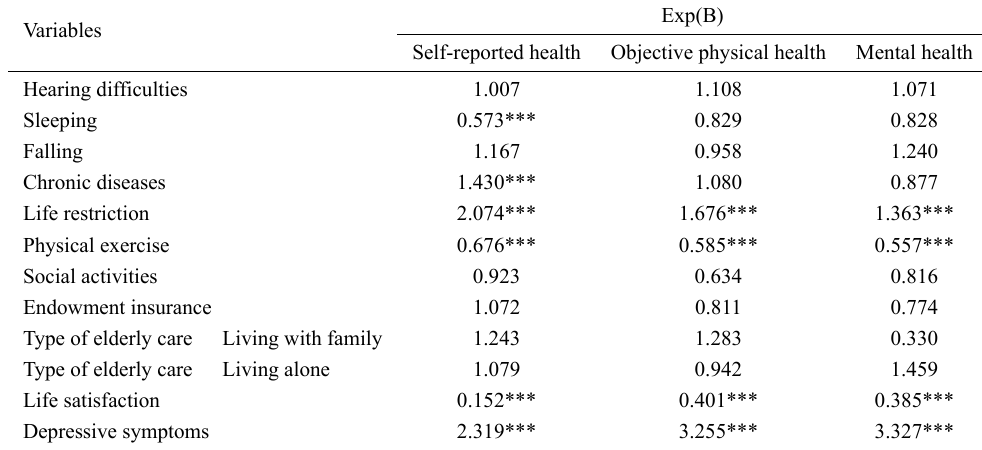
Table 5. Binary regression equation of three dimensions of the widowed elderly health (n =